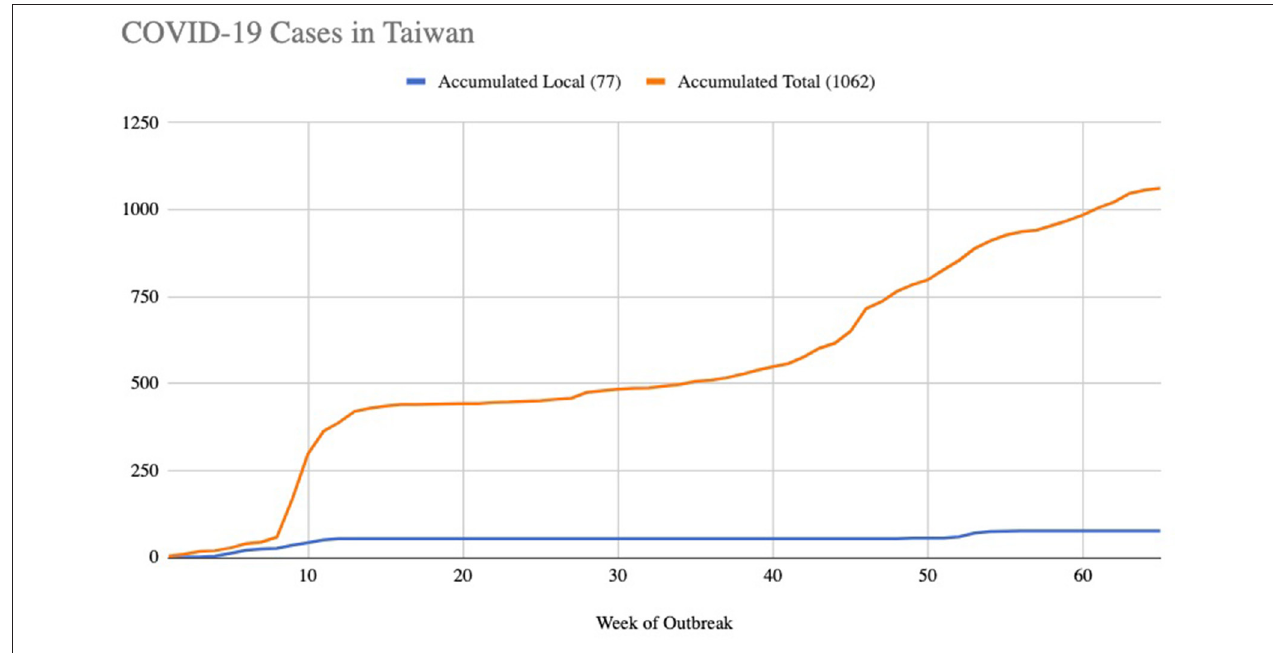
FIGURE 1 | Accumulated number of COVID-19 cases in